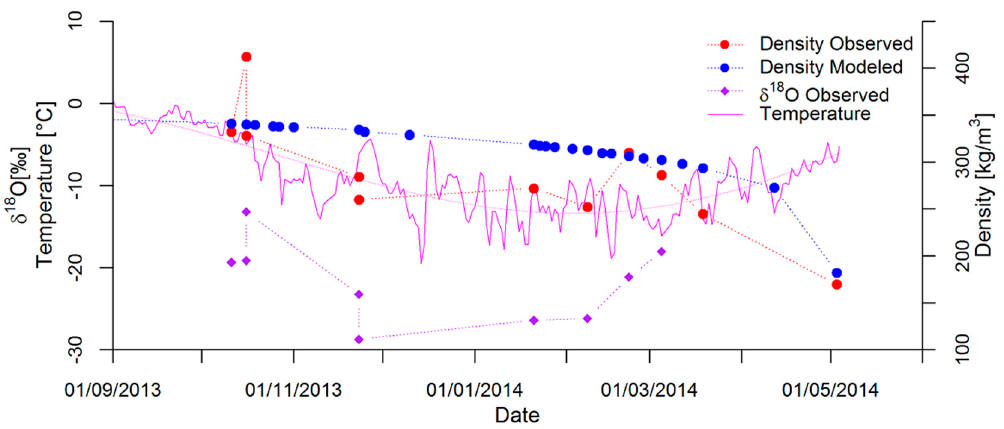
Figure 6. West Khangri Nup EV2CNR station (5601 m asl). Poli-Hydro estimated dates of deposition of the snow layers identified in the snow pit on 4 May 2014, the corresponding simulated and observed snow density of the layer, and the measured isotopic content ( δ 18 O ). Observed temperature also reported. Binomial interpolation of temperature provided to aid general trend assessment.